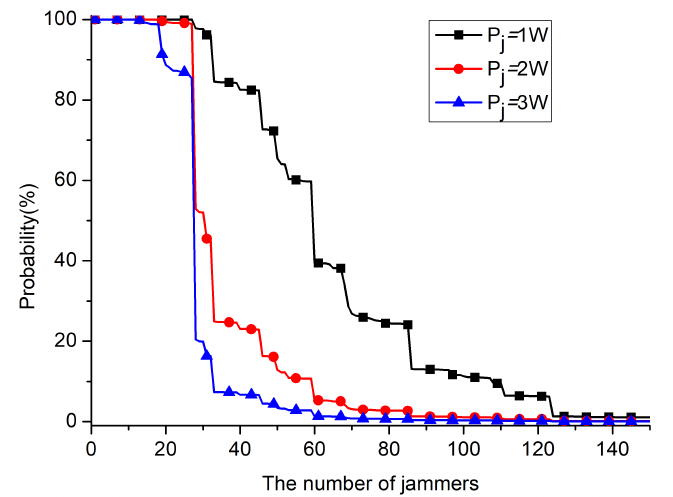
Figure 10. The curve of the radar target detection